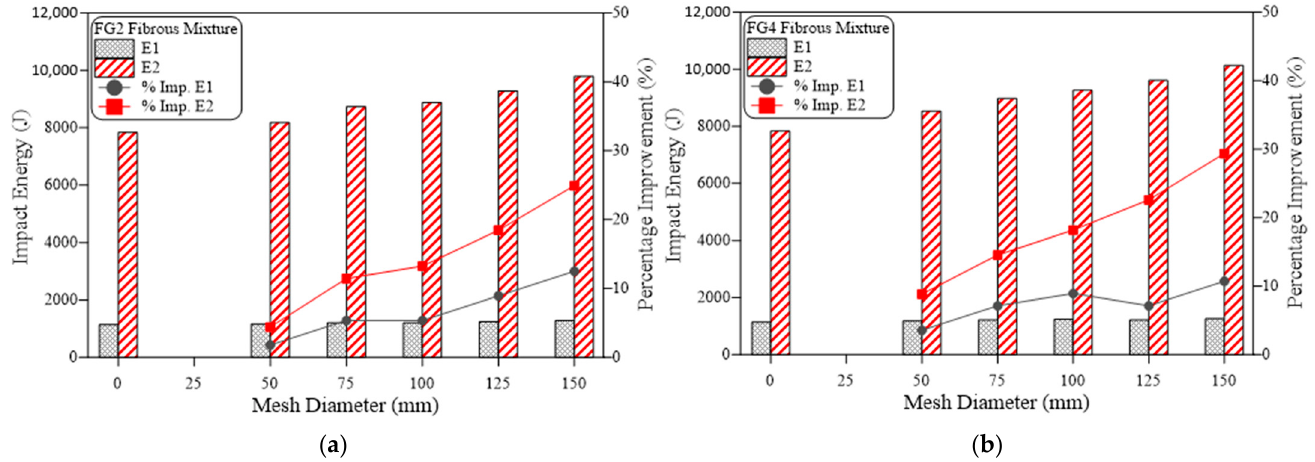
Figure 9. Effect of mesh diameter (ratio of reinforcement surface) on impact energy of fibrous mixtures, ( a ) 2-mesh layers, ( b ) 4-mesh layers.